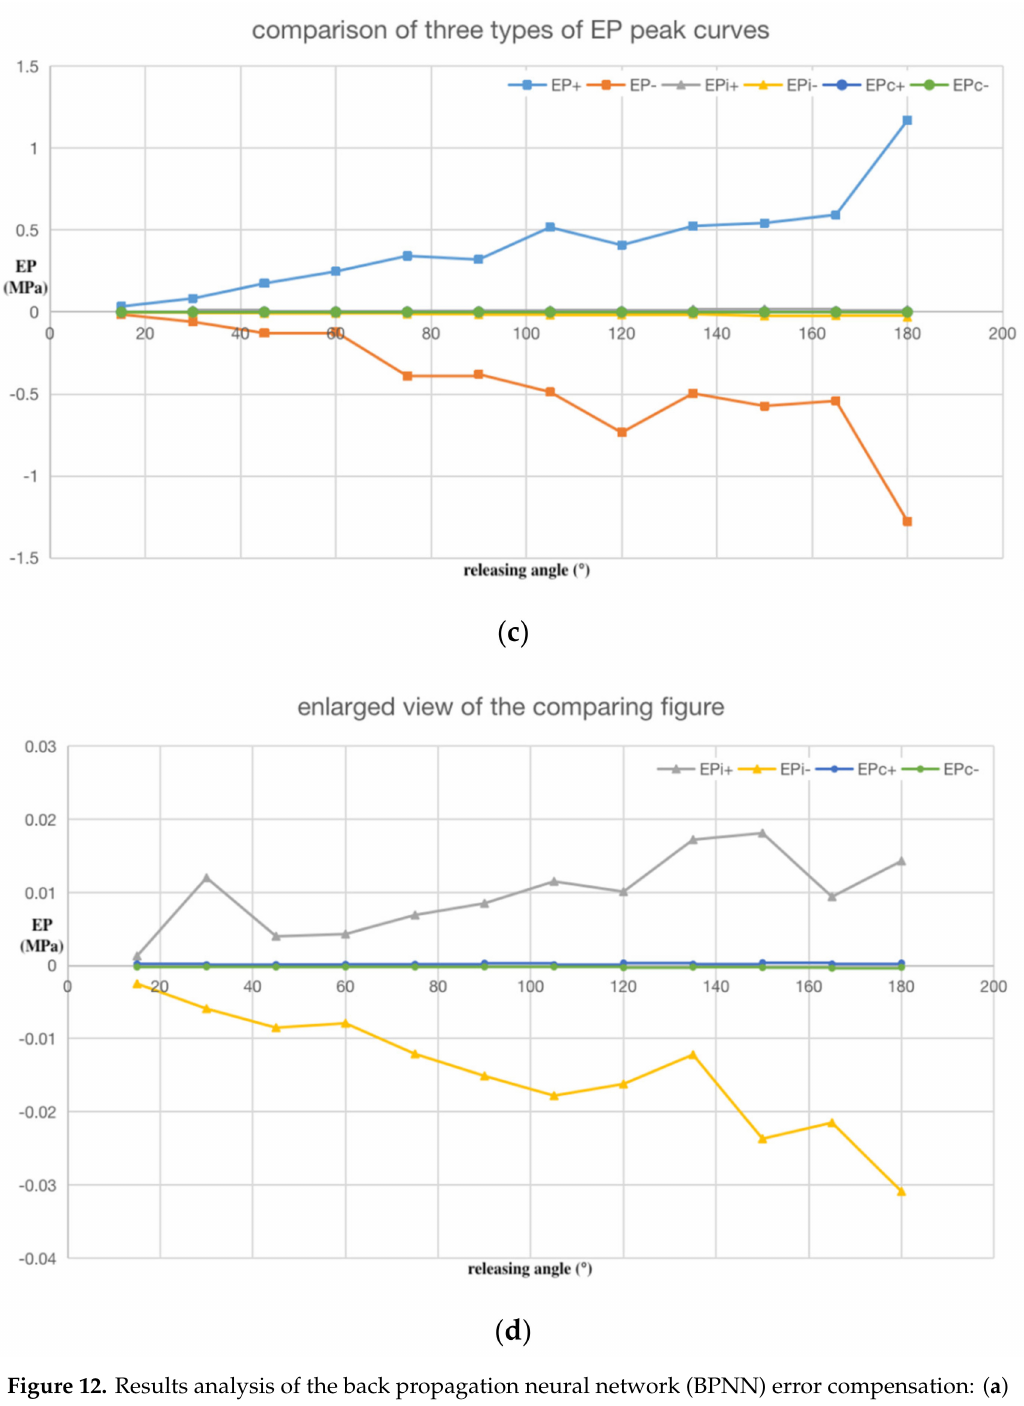
Figure 12. Results analysis of the back propagation neural network (BPNN) error compensation: ( a ) comparing curve of EP, EPi, and EPc at 120 degrees; ( b ) comparing curve of EPi, and EPc at 120 degrees; ( c ) comparison of the maximum peak lines at di ff erent angles; ( d ) is a larger view of